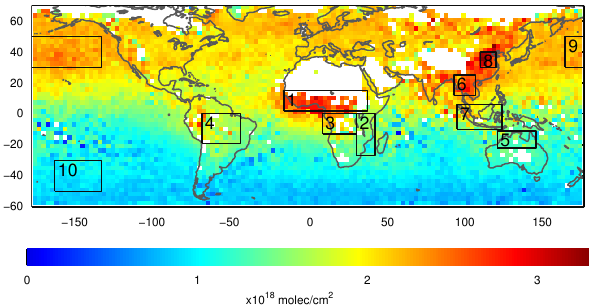
Fig. 8. Mean CO PVCDs (units: moleccm − 2 ) retrieved from SCIA- MACHY (January to March 2003–2005) for CRF >30% and 1km <cloud height <2km. The boxes indicate regions that are selected for quantitative comparison between SCIAMACHY observations and model